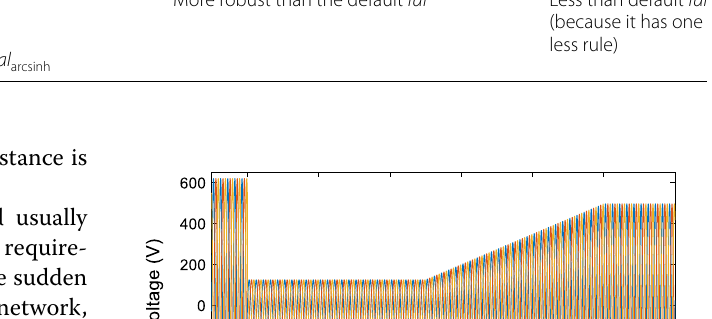
The amount of calculations used during the simulation